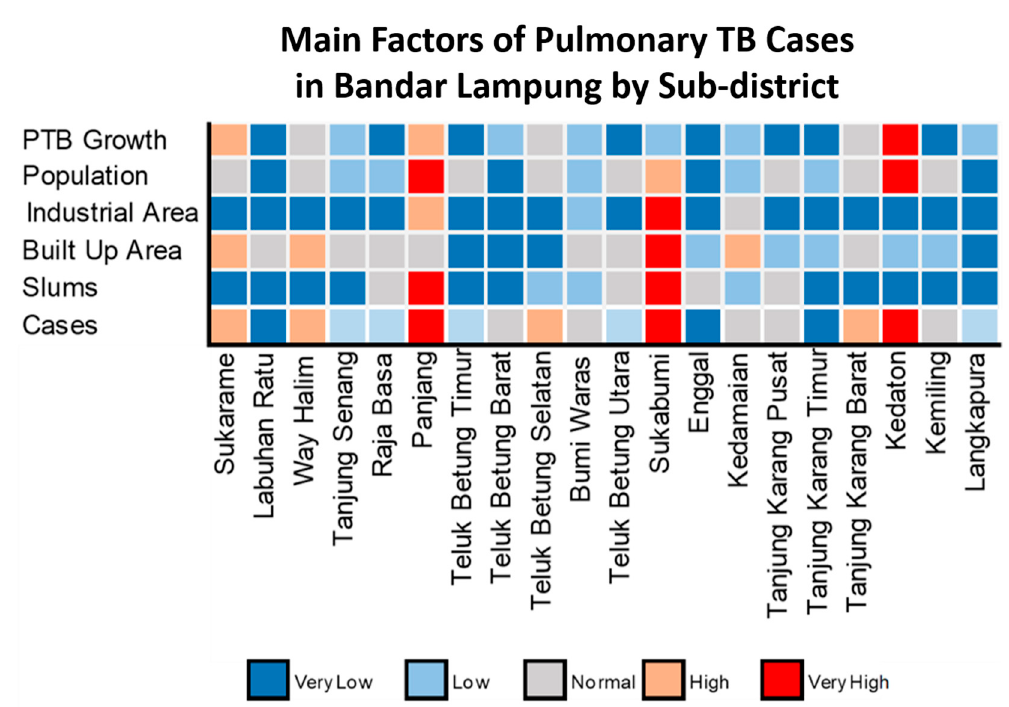
Figure 7. Spatial variations of pulmonary TB cases, pulmonary TB growth rate, population, built area, industrial area, and slums.